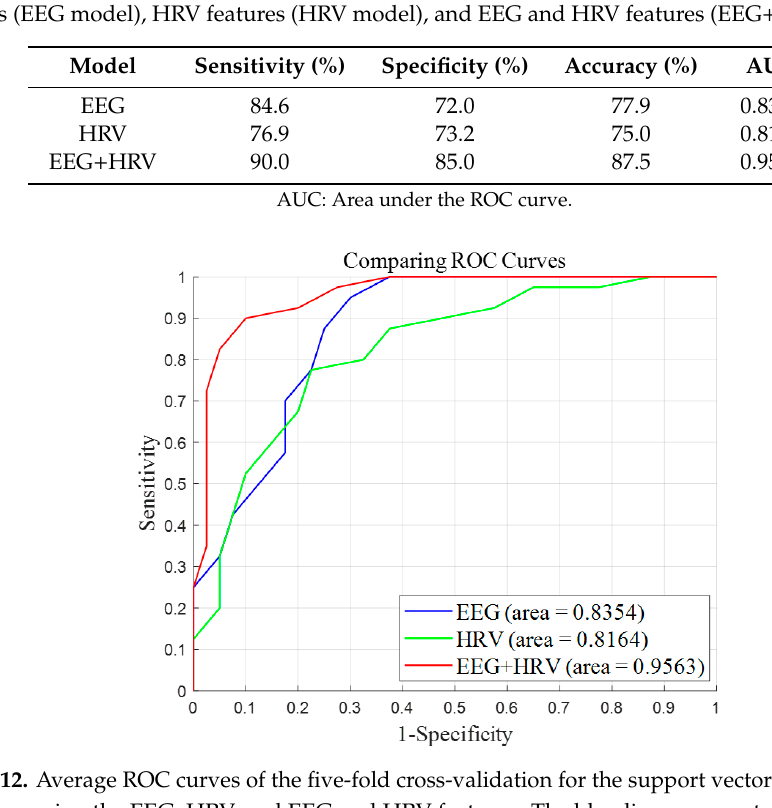
Table 3. Five-fold cross-validation results for the support vector machine (SVM) classifiers using EEG